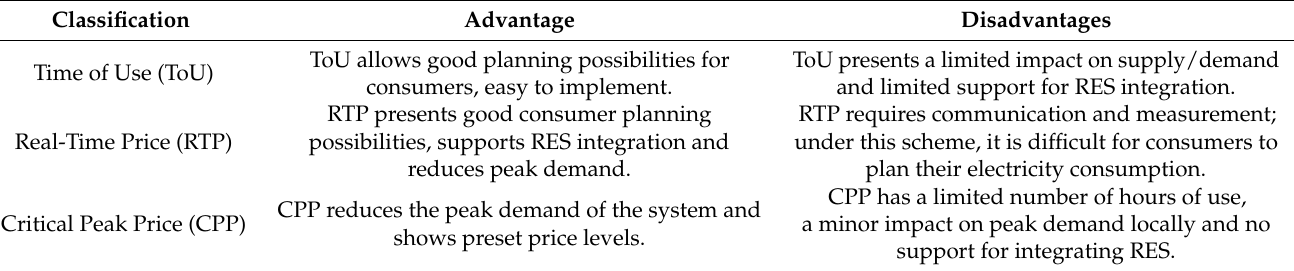
Table 1. Price-based